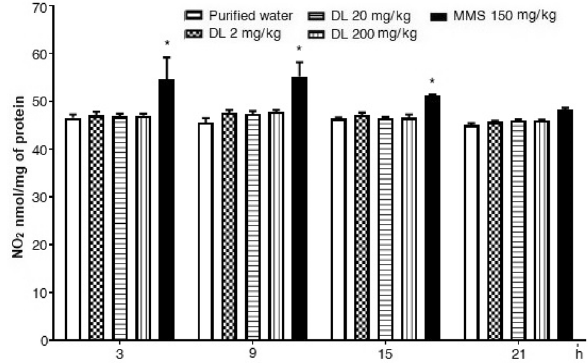
Figure 8. Effect of duloxetine (DL) and methyl metanesulfonate (MMS) on the content of nitrites (NO 2 ) in mouse brain cells. Each bar corresponds to the mean ± SEM obtained in 5 independent determinations made in triplicate. * Statistically significant difference with respect to control value. ANOVA and post hoc Student– Newman–Keuls tests ( p ≤ 0.05).